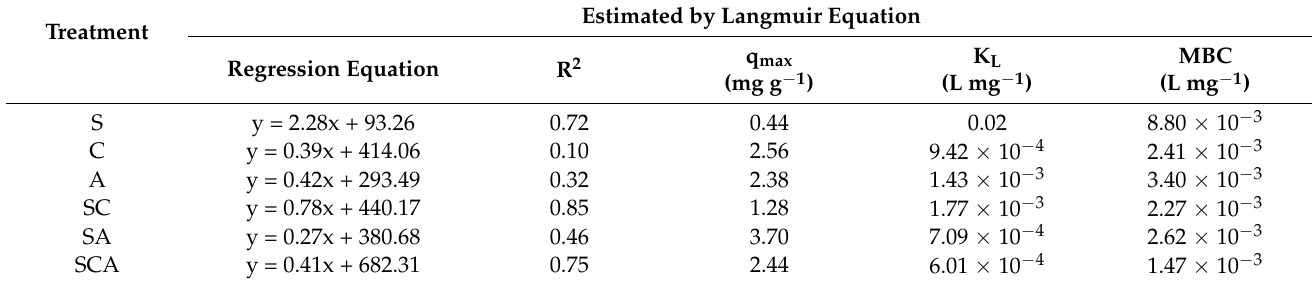
Table 4. Effects of treatments on phosphorus sorption parameters of the isotherm described by Langmuir equation. Estimated by Langmuir Treatment